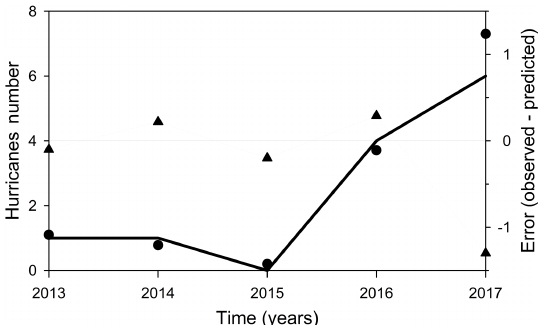
Figure 8. Prediction of the hurricanes number in the Gulf of Mexico and the Caribbean Sea by means of non-linear methods, and the en- tropy test. The solid black line represents the number of hurricanes observed from 2013 to 2017. The black points are the prediction and the triangles are the error in the prediction, considered as the observed values minus the predicted